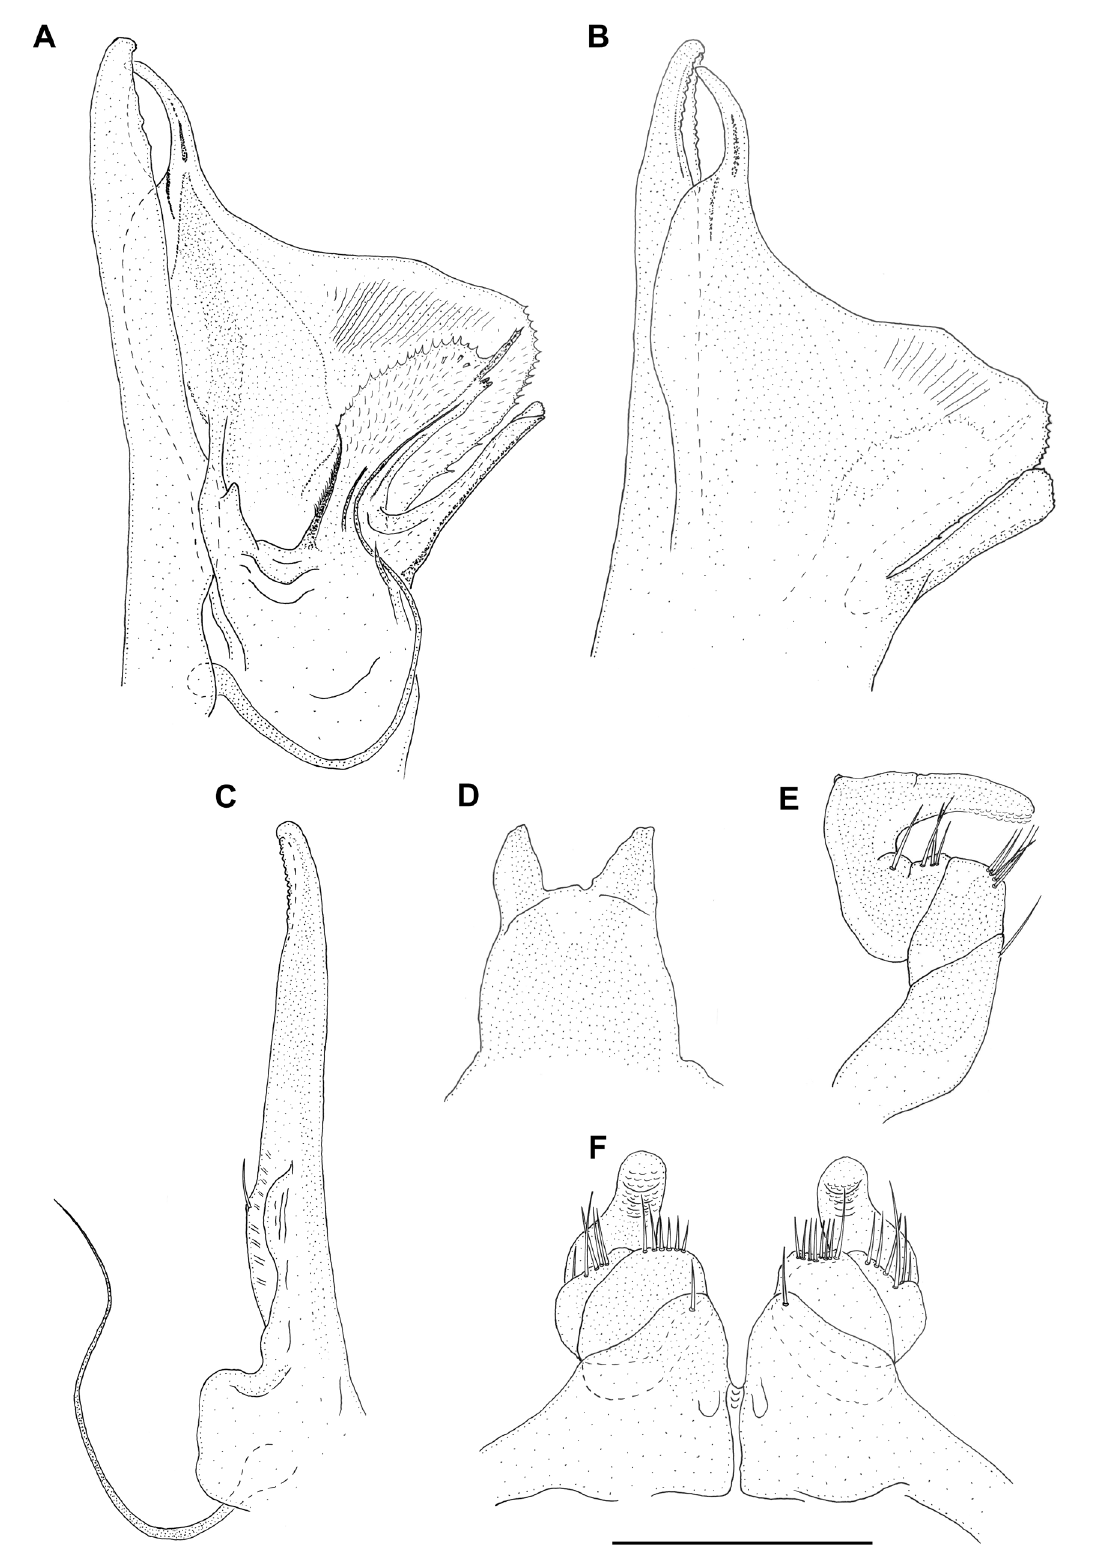
Fig. 35. Leucogeorgia prometheus sp. nov., paratype ♂ from Prometheus Cave (IZISU). A . Left gonopods, mesal view. B . Right gonopods, lateral view. C . Left promere, lateral view. D . Penes, posterior view. E . Left leg 1, lateral view. F . Leg-pair 1, anterior view. Scale bar: 0.3